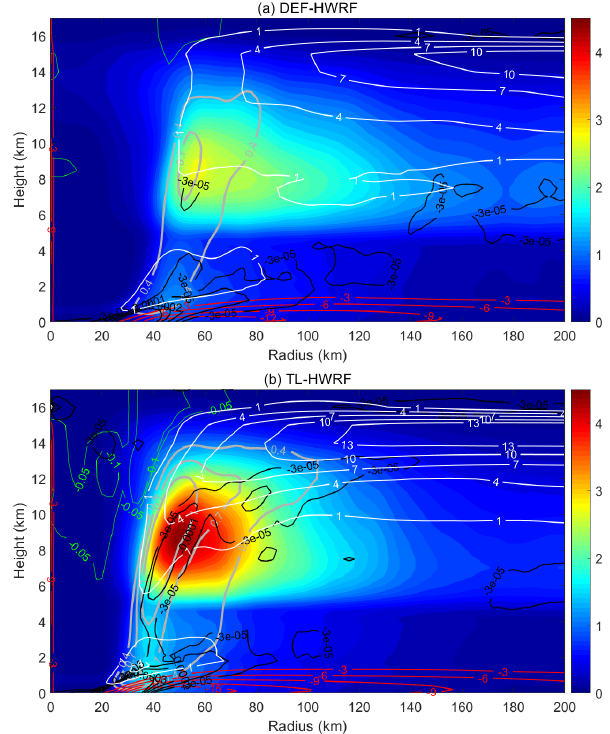
Figure 10. Simulated azimuthal-mean radius–height structure of updrafts (thick gray contours; ms − 1 ), downdrafts (green contours; ms − 1 ), hydrometeor mixing ratio (colored shading; gkg − 1 ), ra- dial inflow (red contours; ms − 1 ), outflow (white contours; ms − 1 ), and radial flow convergence (black contours; s − 1 ) averaged over Jimena’s RI period from 06:00UTC, 28 August, to 06:00UTC, 29 August